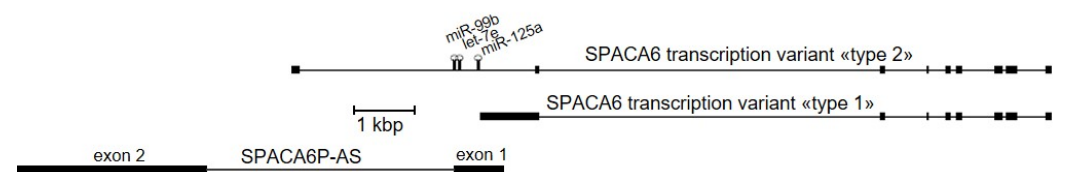
Figure 1. Human Spaca6/microRNA (miRNA) cluster locus. Top lines show the two main transcripts of SPACA6 gene, each yielding different splice variants. The bottom line refers to SP-AS that is transcribed in the opposite direction. Exons and miRNAs are indicated by black boxes and loops, respectively.